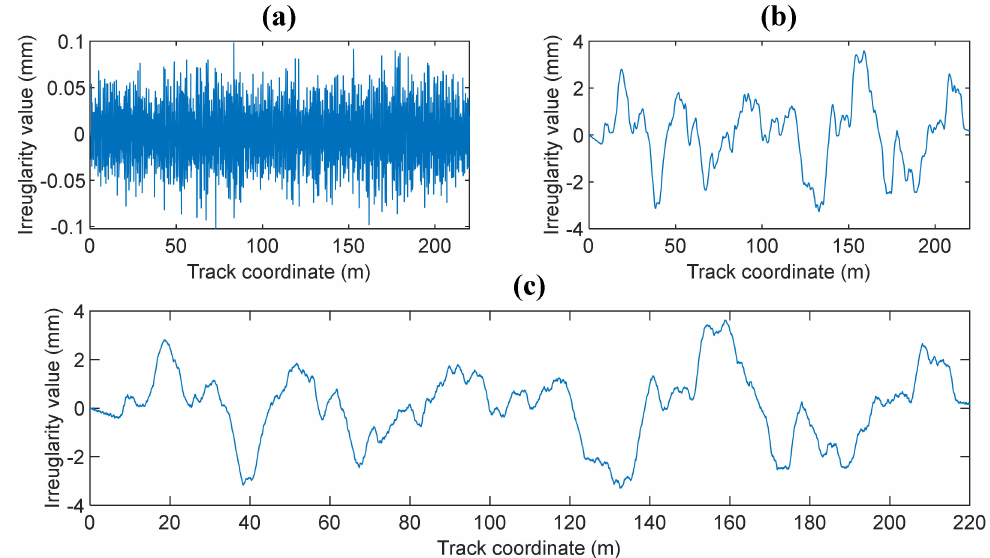
Figure 4. Samples of the: ( a ) short wavelength; ( b ) middle long wavelength; ( c ) combined random track